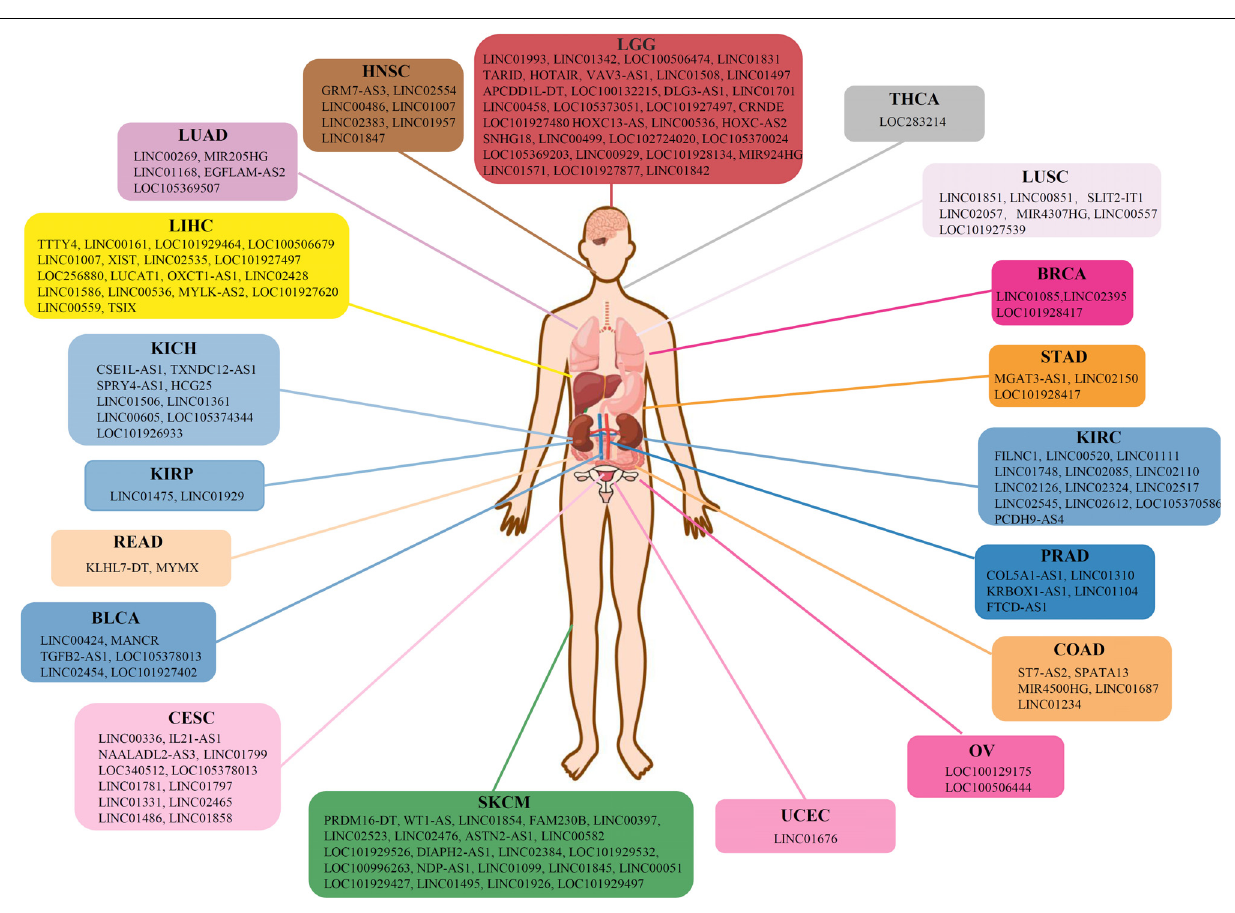
FIGURE 4 | Gene symbols of corresponding lncRNA markers in 19 solid